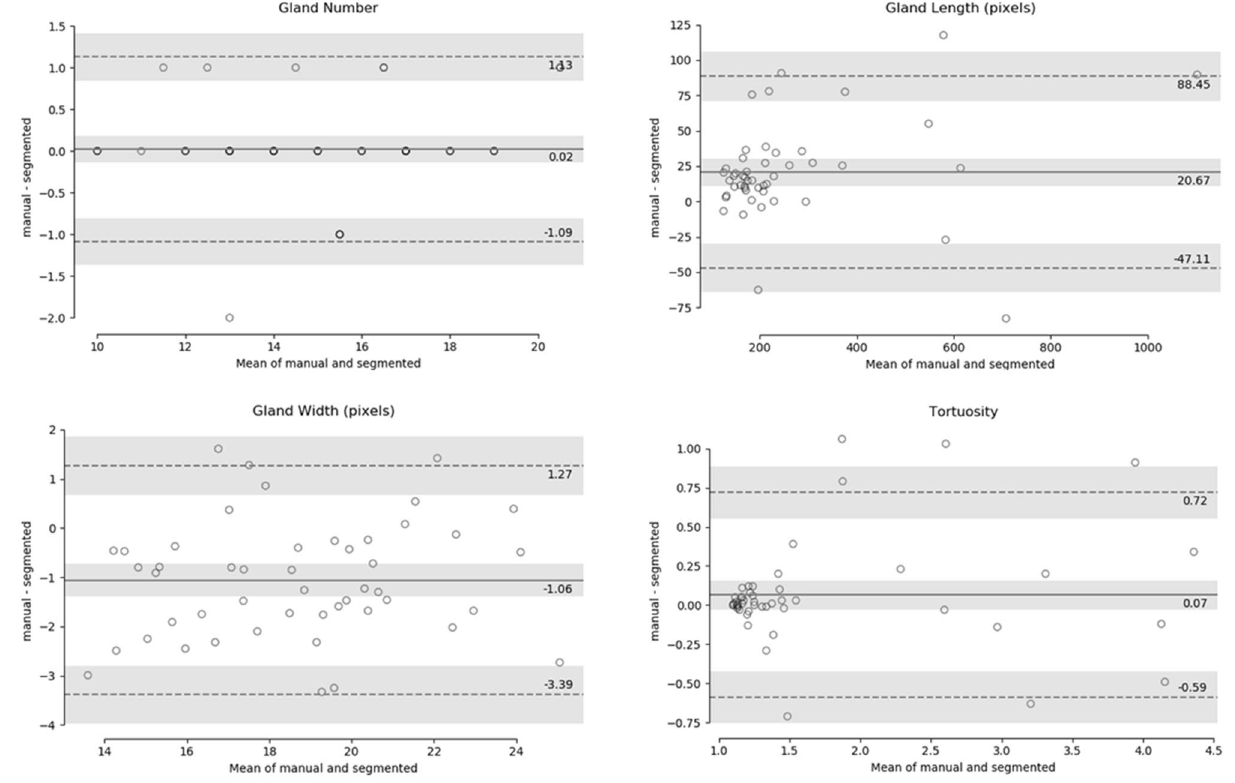
Figure 6. Bland–Altman plots of MGs number, length, width, and tortuosity between ground truth and deep learning segmentation for upper eyelid. The middle solid line indicates the mean value, the two dotted lines indicate the limit of agreement (± 1.96 SD), and the gray bar indicates the confidence interval of